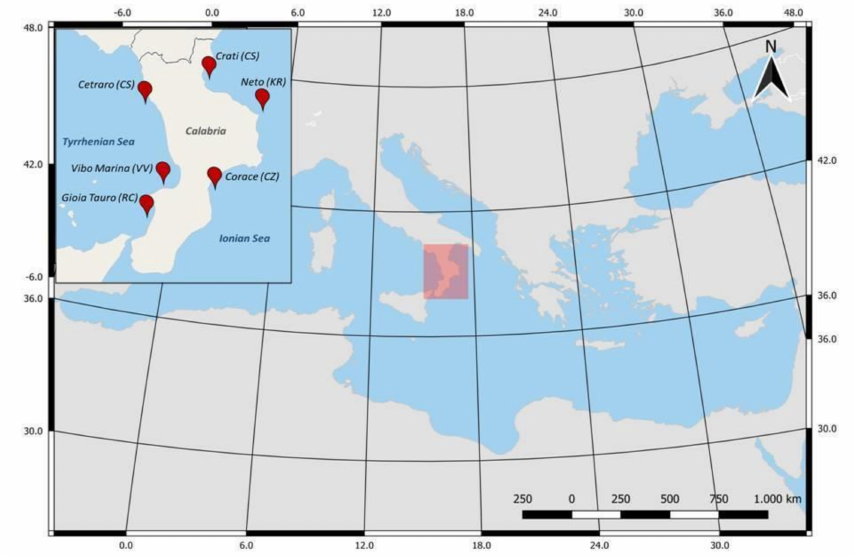
Figure 1. Sampling stations in Ionian (Corace, Neto, and Crati) and Tyrrhenian (Gioia Tauro, Vibo Marina, and Cetraro) coasts of